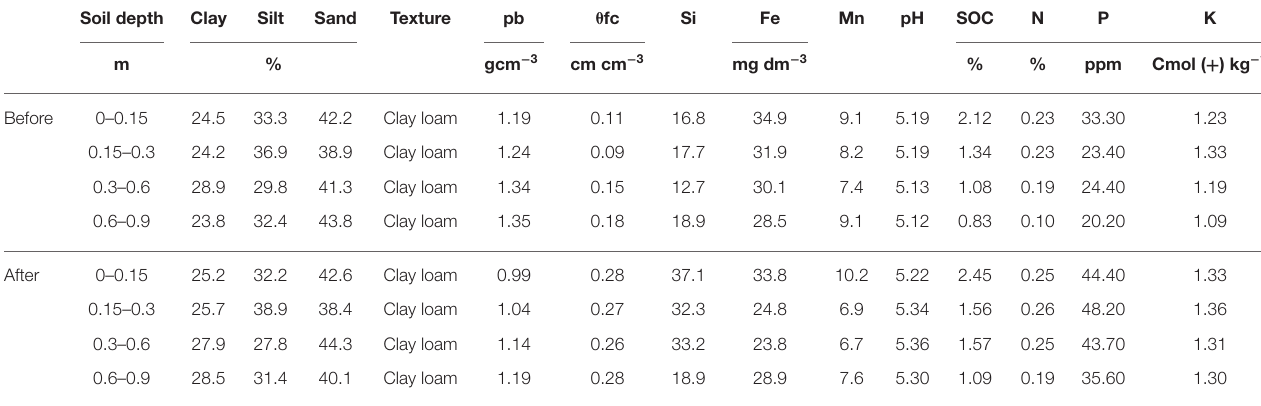
TABLE 1 | Soil properties measured before and after the